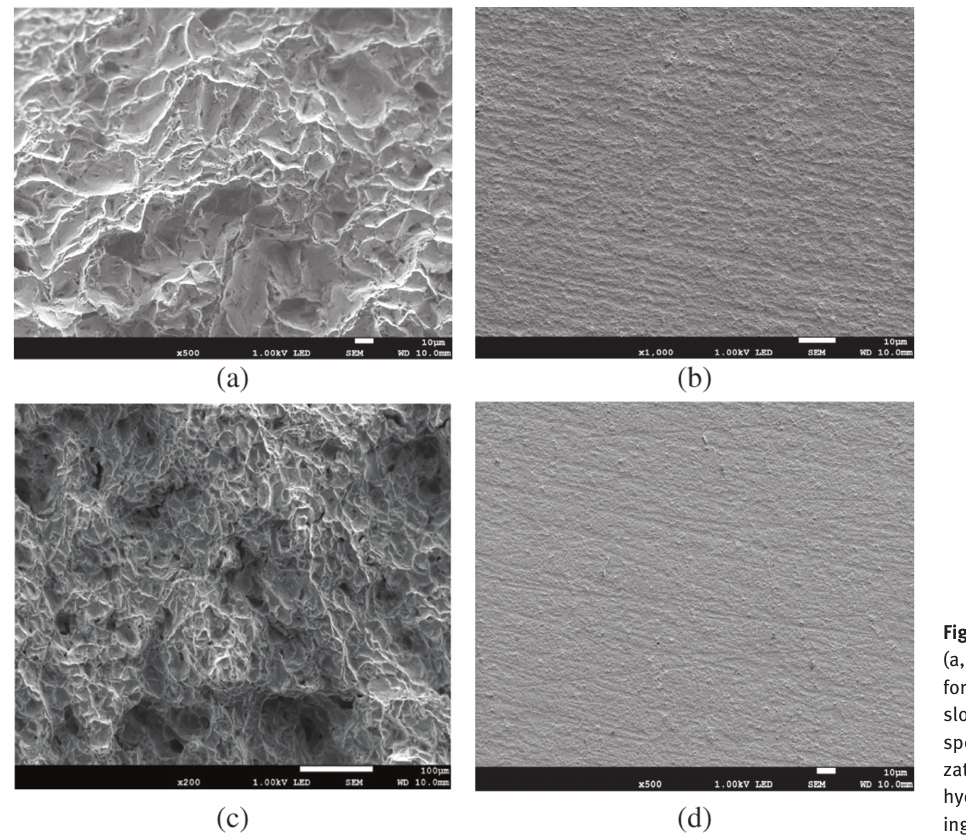
Figure 4 demonstrates the fracture faces of both materi- als, either only oxidized at 350 °C or oxidized, hydrogen charged and annealed. The intercrystalline crack paths with many dimples and totally ductile fracture were observed for both alloys. The brittle behavior was noticed only near the cracks.